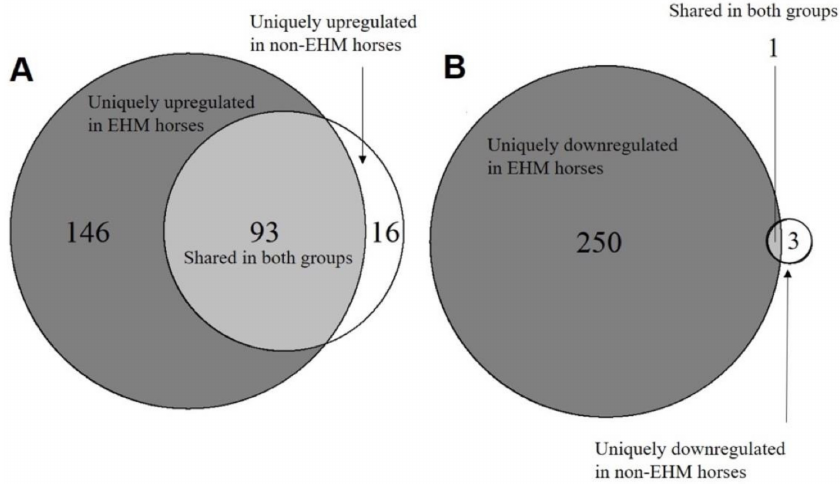
Figure 6. Venn diagrams of up- and downregulated genes in response to EHV-1 challenge. The within group comparisons for EHM and non-EHM horses were compared using a Venn diagram to determine genes uniquely ( A ) upregulated and ( B ) downregulated for each group.